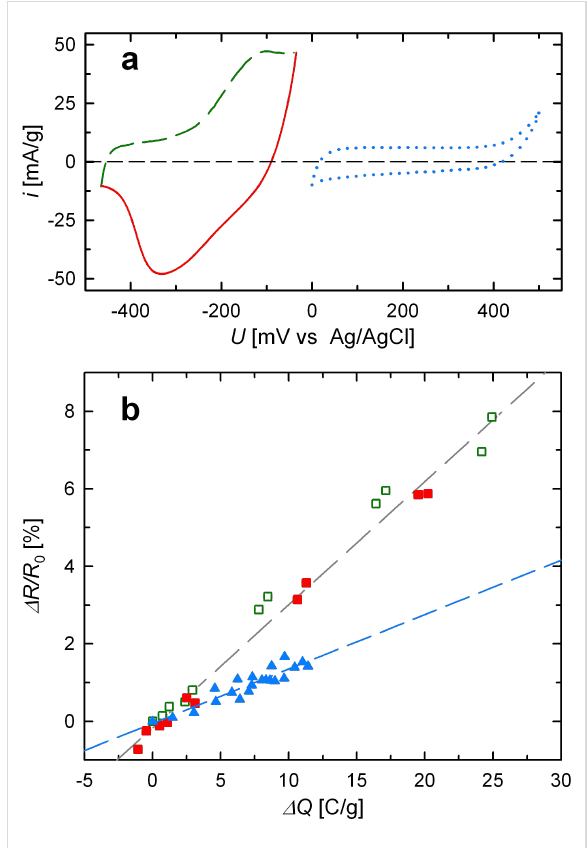
Figure 4: Relative variation of electrical resistance Δ R / R 0 of sample Pt ER upon adsorption (green: dashed line, open squares) and desorp- tion (red: solid line, full squares), and upon charging in the regime of strong oxygen adsorption (blue: dotted line, full triangles) in 1 M KOH. (a) CVs measured in the respective potential ranges. (b) Variation of Δ R / R 0 with charge Δ Q imposed upon chronoamperometry (CA) in the potential regimes shown in (a).